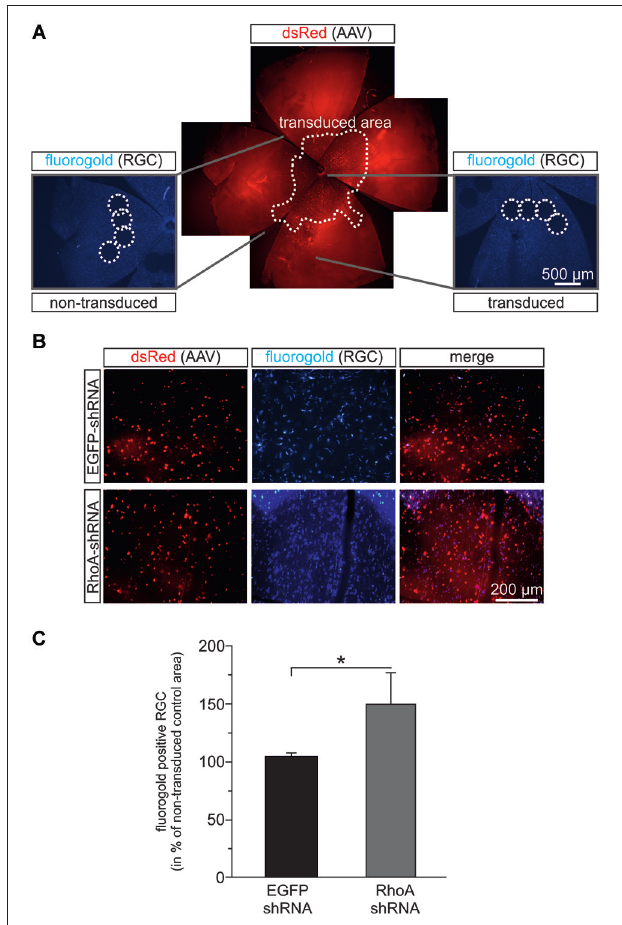
FIGURE 5 | RhoA-shRNA increases RGC survival after optic nerve axotomy . (A) Composite figure explaining the evaluation method used to assess RGC-survival after optic nerve axotomy. Retina flat mounts were obtained 14 days after transection of the optic nerve. Per retina, four view fields were evaluated in a region that was not transduced by the AAV (dashed circles in the left micrograph) and directly compared to four view fields in an AAV-transduced region (dashed circles on the right micrograph) of the same retina in a similar distance from the optic disc. (B) Representative micrographs of transduced view fields from retina flat mounts transduced with the given AAV in red and Fluorogold positive cells in blue. (C) Quantification of the number of Fluorogold-positive RGC given in percent of AAV.EGFP-shRNA control (set to 100%) ( n = 7 retinas for AAV.EGFP-shRNA and n = 8 retinas for AAV.RhoA-shRNA; bars represent means ± SEM; * p < 0.05 according to Wilcoxon (Mann-White) test for unpaired